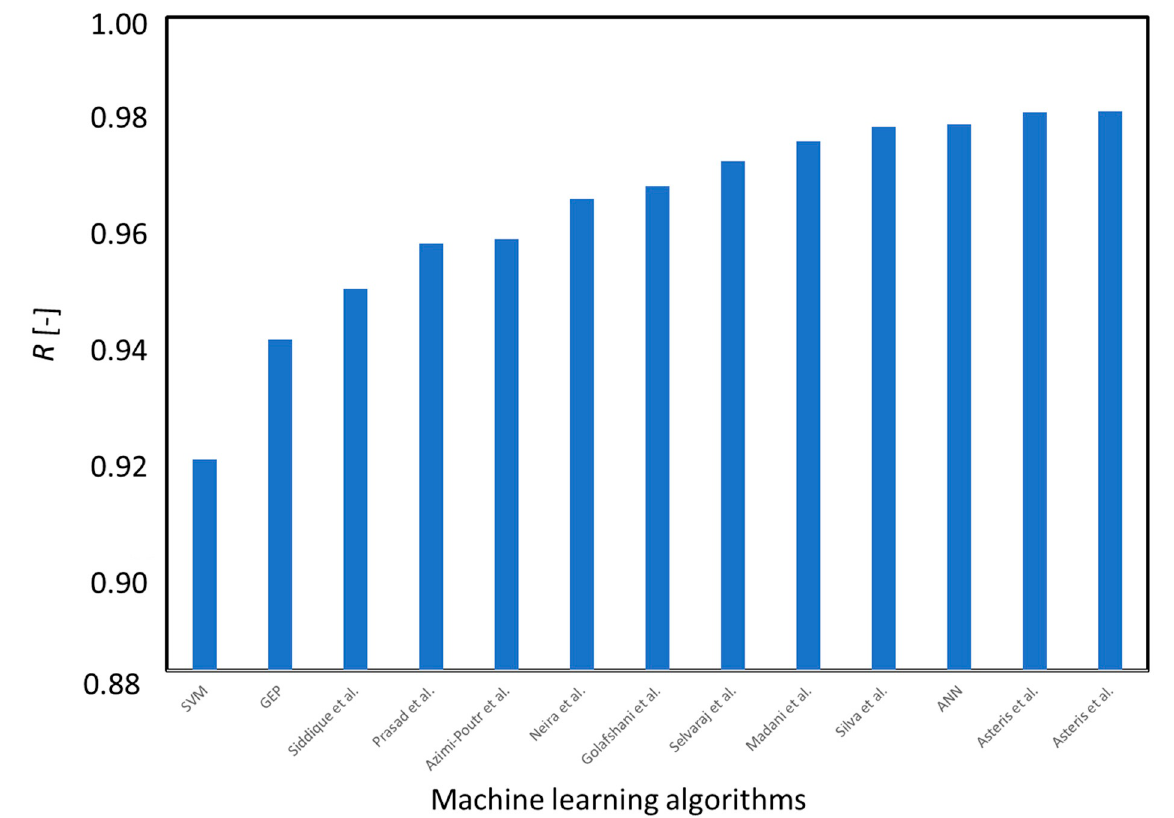
Figure 11. The comparison of models for SCC compressive strength prediction.